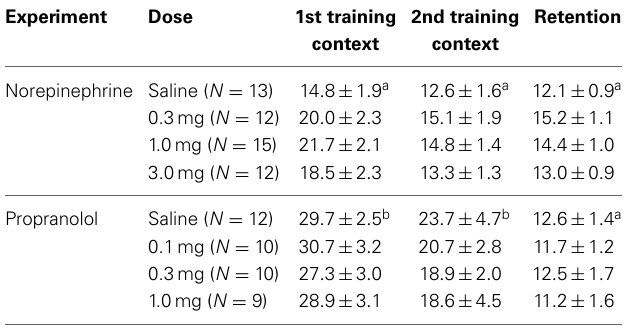
Table 1 | Total object exploration time.